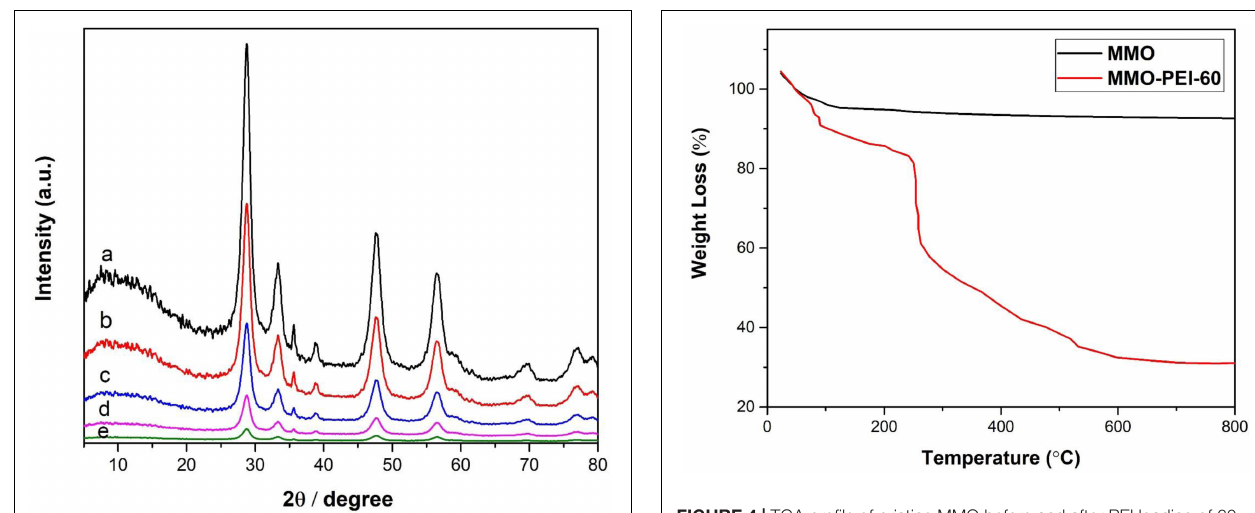
FIGURE 4 | TGA profile of pristine MMO before and after PEI loading of 60